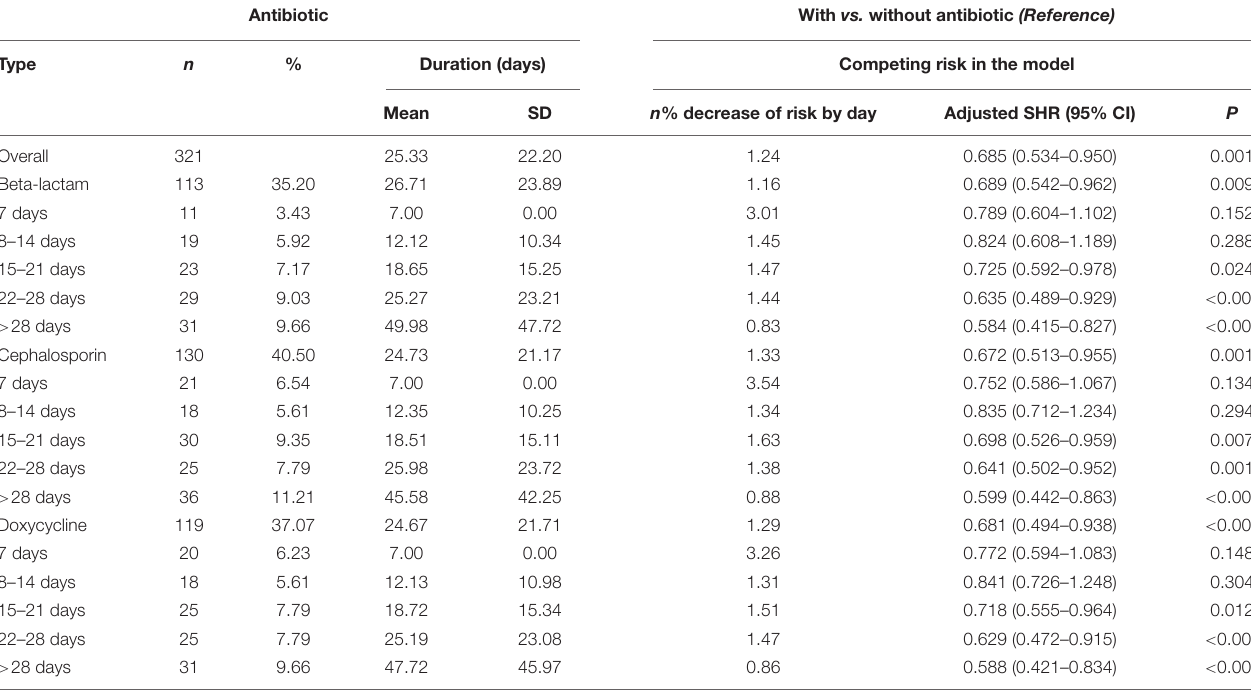
TABLE 5 | Percentage, duration, percentage of decrease of risk by days, and adjusted sub-distribution hazard ratios of antibiotic among Leptospirosis infections patients. Antibiotic With vs. without antibiotic (Reference)